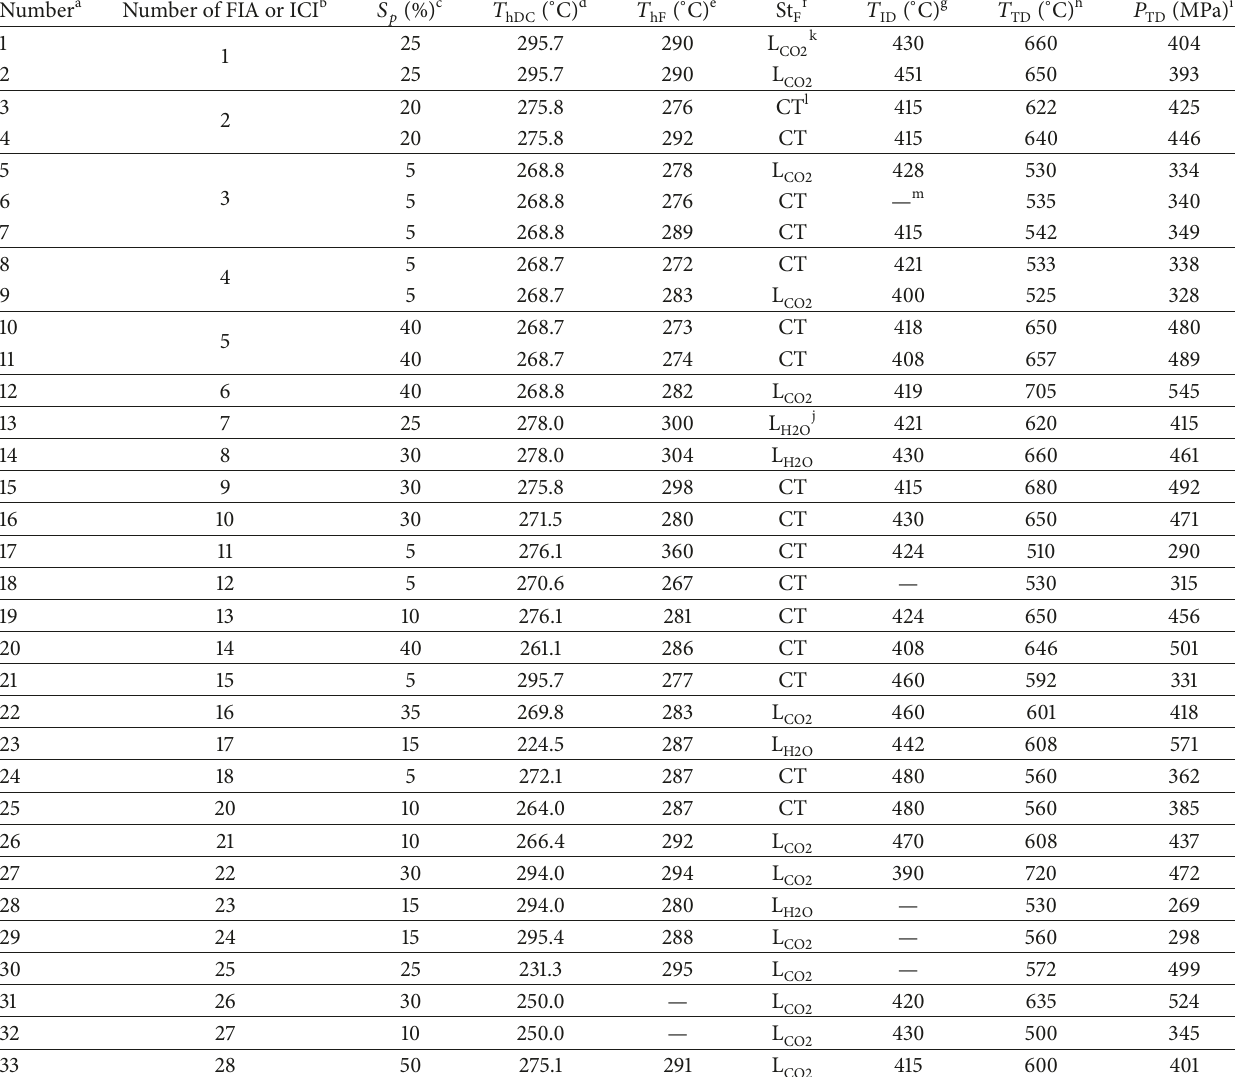
Table 1: Results of homogenization experiments of CIs in spodumene from Jiajika deposit under external pressures in HDAC. Number